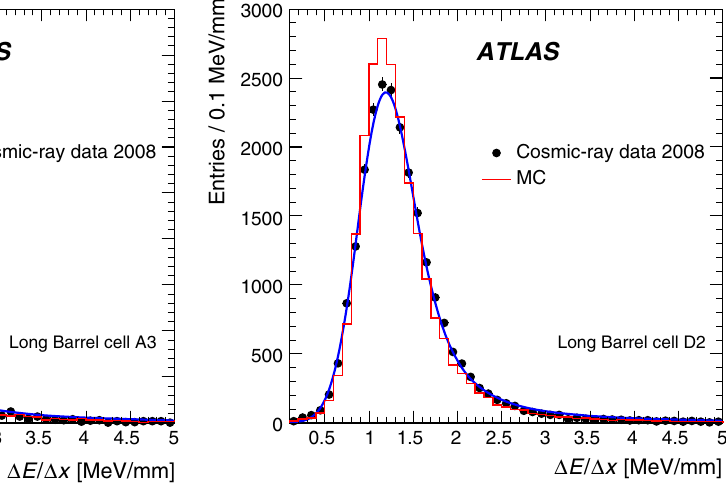
the region 0 . 2 < | η | < 0 . 3 (0 . 3 < | η | < 0 . 5) and is located in the innermost (outermost) calorimeter layer. The function curve overlaid on top of the experimental data is a Landau distribution convolved with a Gaussian